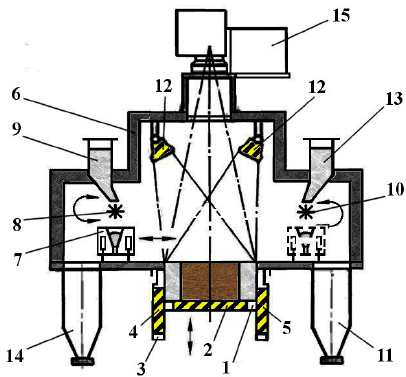
Figure 1. Schematic view of the SLS machine for manufacturing parts made of the PEEK